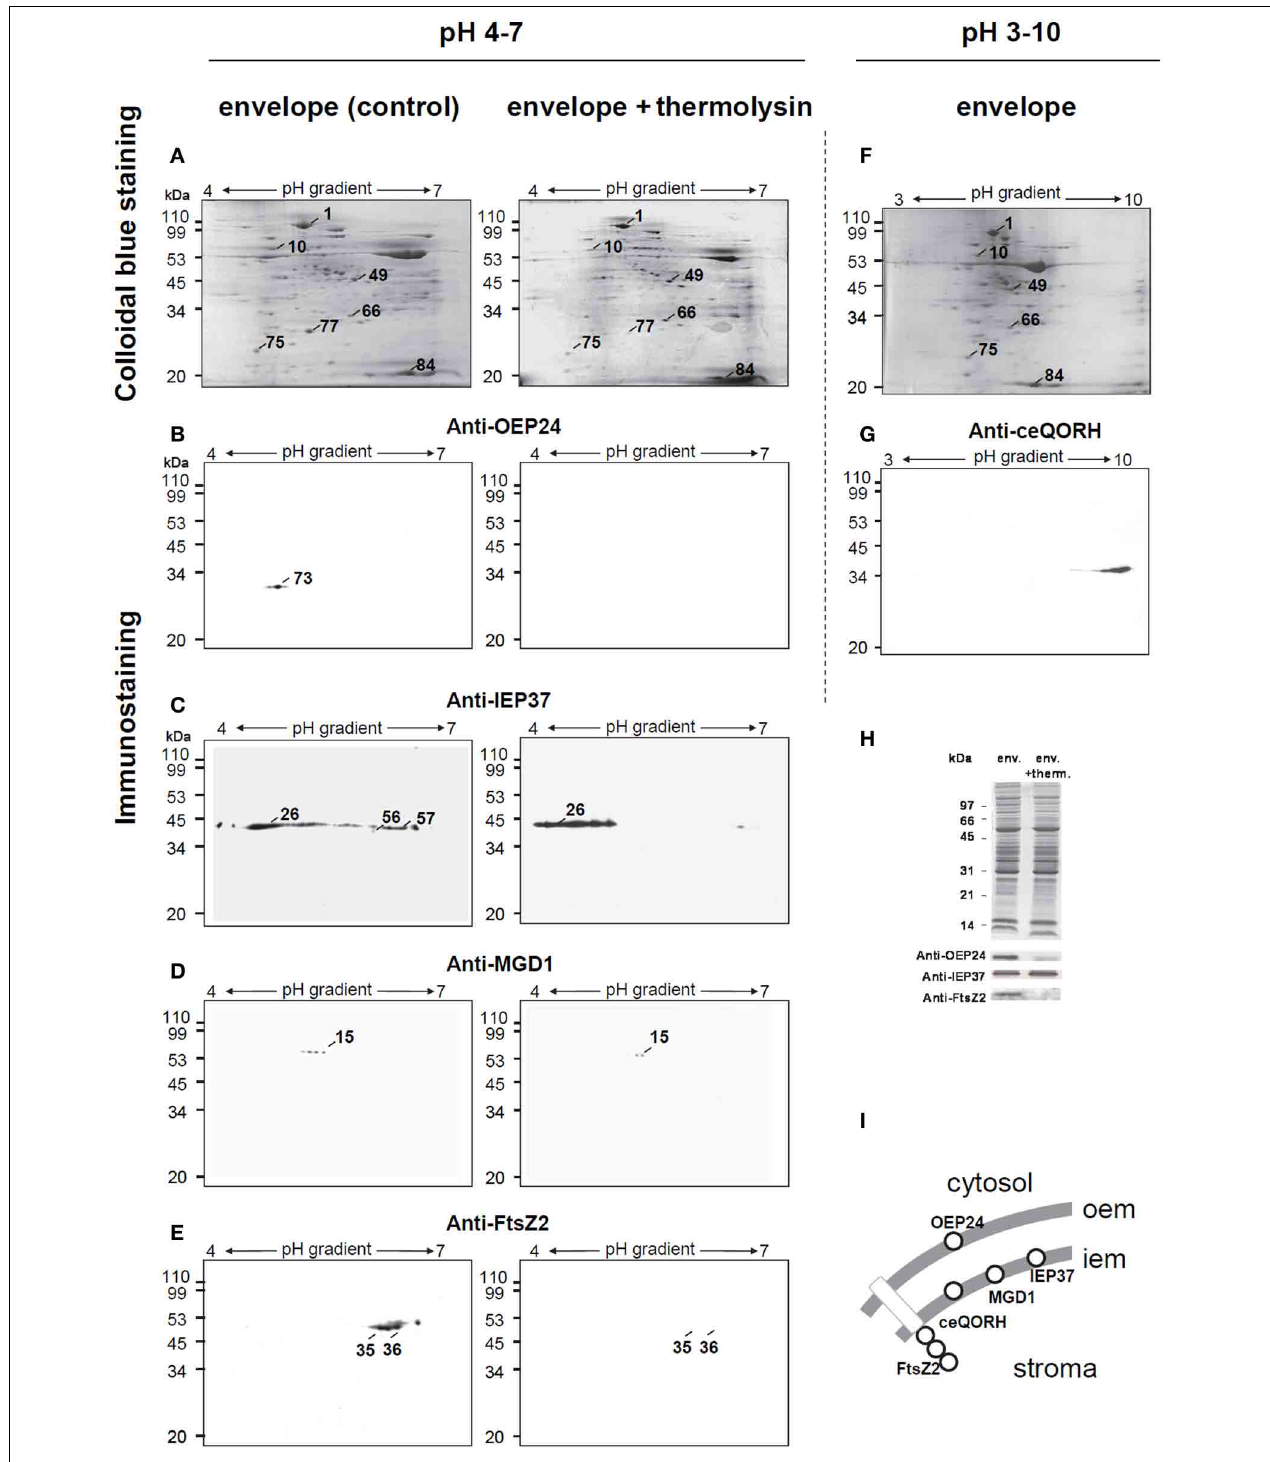
FIGURE 4 | Two-dimensional analysis of envelope proteins prepared from thermolysin treated intact spinach chloroplast. (A–D) Isolated intact spinach chloroplasts were incubated in the absence (control) or presence ( + thermolysin) of the non-permeable protease thermolysin. After chloroplast disruption, envelope sub-fractions were recovered. Envelope proteins